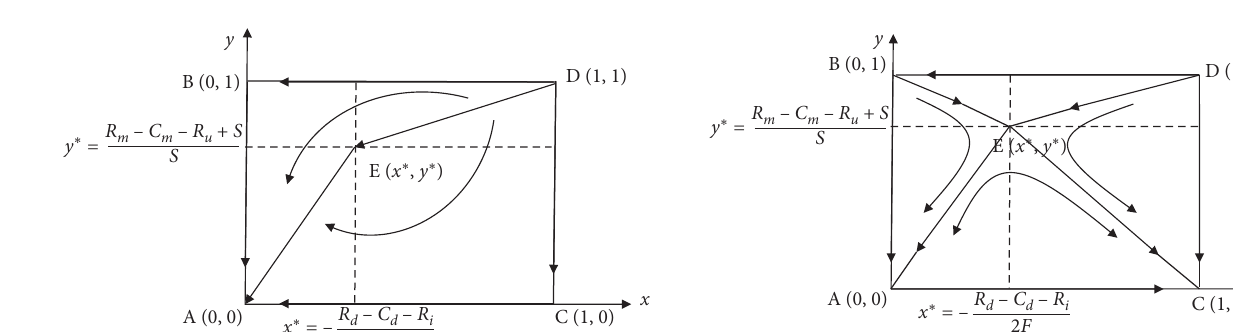
Figure 7: The replication dynamic phase map for scenario